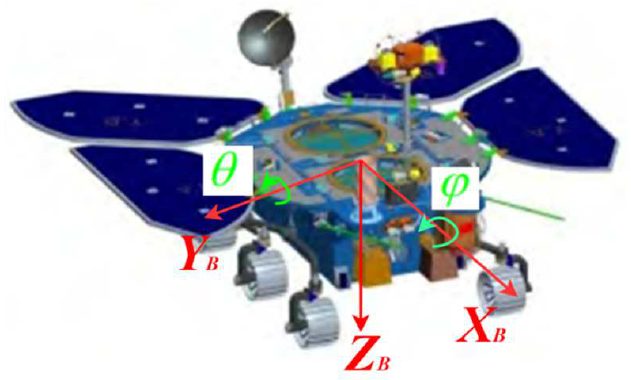
Figure 5. The body frame of